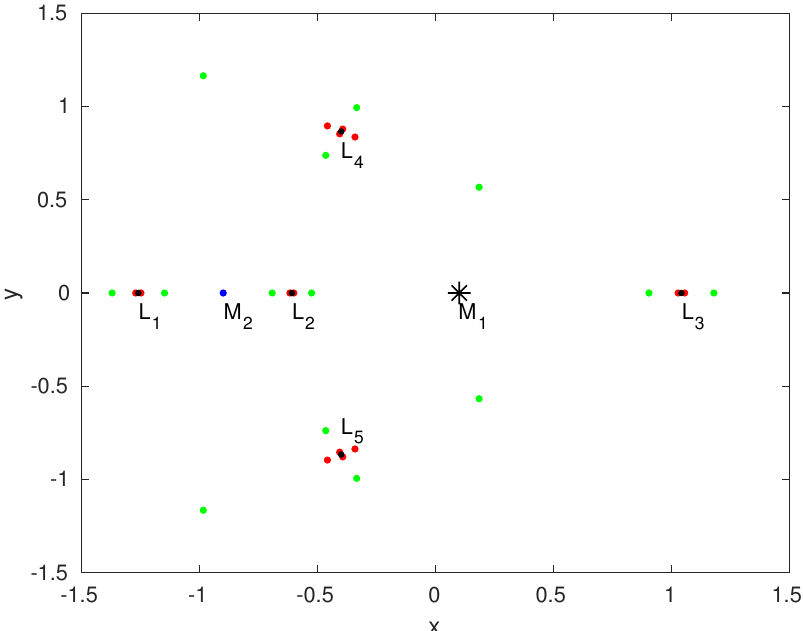
Figure 2. The position of equilibrium points when µ = 0.1, µ 1 = 0.01, µ 2 = 0.001, M a = 3 × 10 − 7 , and parameter T = 0.11. The positions of the primaries are M 1 and M 2 , represented by an asterisk and blue dot, respectively. L 1 , L 2 , L 3 , L 4 , and L 5 with black dots are the Lagrangian points of CRTBP. The equilibrium points of R2+2BP with the planetesimal belt effect are shown in green and red dots for P 1 and P 2 , respectively.